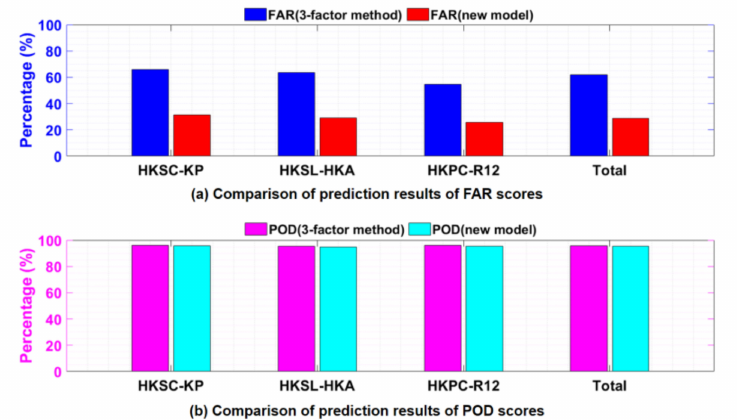
Figure 7. Comparison of prediction results of FAR ( a ) and POD ( b ) scores from the new model and 3-factor method at each